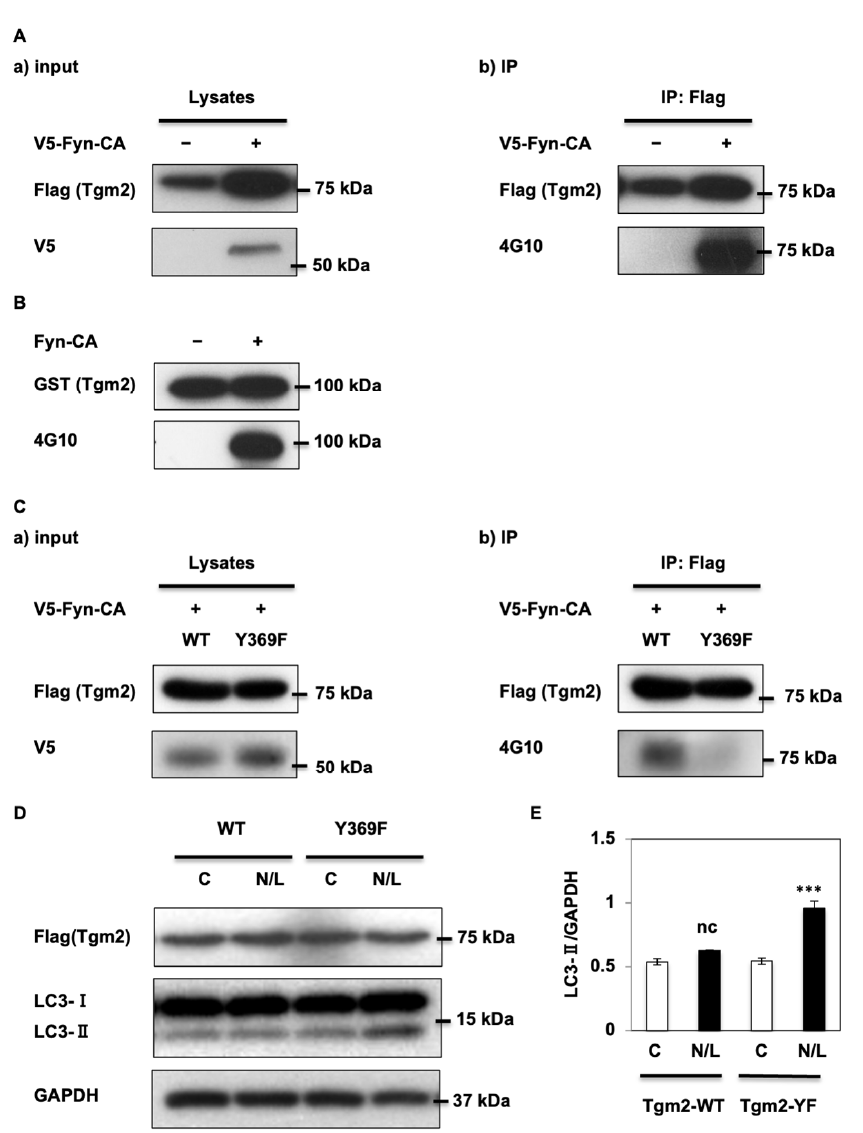
Figure 3. Fyn kinase phosphorylates Tgm2 on the tyrosine 369 (Y369) residue. ( A ) 48 h after HEK-293T cells were co-transfected with Flag-Tgm2 and V5-Fyn-CA, Tgm2 immunoprecipitation was performed using a Flag antibody followed by Western blotting. Blots are representative images of three independent experiments. ( B ) Purified human glutathione S-transferase (GST)-Tgm2 and either mock or Flag-Fyn-CA were incubated at 30 ◦ C with Src kinase buffer supplemented with ATP for 30 min. Western blotting was performed with the indicated antibodies. ( C ) 48 h after HEK-293T cells were co-transfected with V5-Fyn-CA and Flag-Tgm2 or Flag-Tgm2-Y369F, immunoprecipitation was performed using a Flag antibody followed by Western blotting with the indicated antibodies. Blots are representative images of three independent experiments. ( D ) Cells were transfected with the native form (wild-type WT) or the Y369F-Tgm2 mutant (Y369F) and treated with (N/L) or without (C) NH 4 Cl and Leupeptin for 2 h. Tgm2 and LC3 expression levels were determined using immunoblotting and ( E ) the signals were quantified. Data are shown as the mean ± s.e.m., *** p < 0.001.